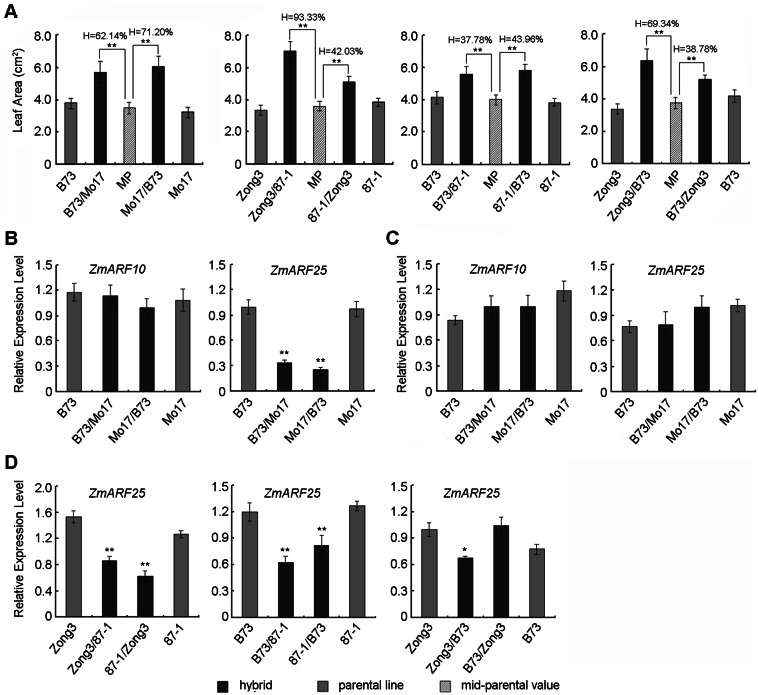
The third leaf areas and expression patterns of ZmARF10 and ZmARF25 between maize hybrids and their parental lines. (A) The third leaf area and mid-parent heterosis at the 8 DAG. H represents mid-parent heterosis (MPH). **refers to significant at p<0.01, data are represented as the mean ± SE (n = 3). (B–D) Expression patterns of ZmARF10 and ZmARF25 in different leaf regions of maize hybrids and their parental lines at the 5 DAG. B, C and D indicated as basal region, tip region and basal region, respectively. β-actin was used as an endogenous control. Data are represented as the mean ± SE (n = 3), *refers to significant at p<0.05, **refers to significant at p<0.01.